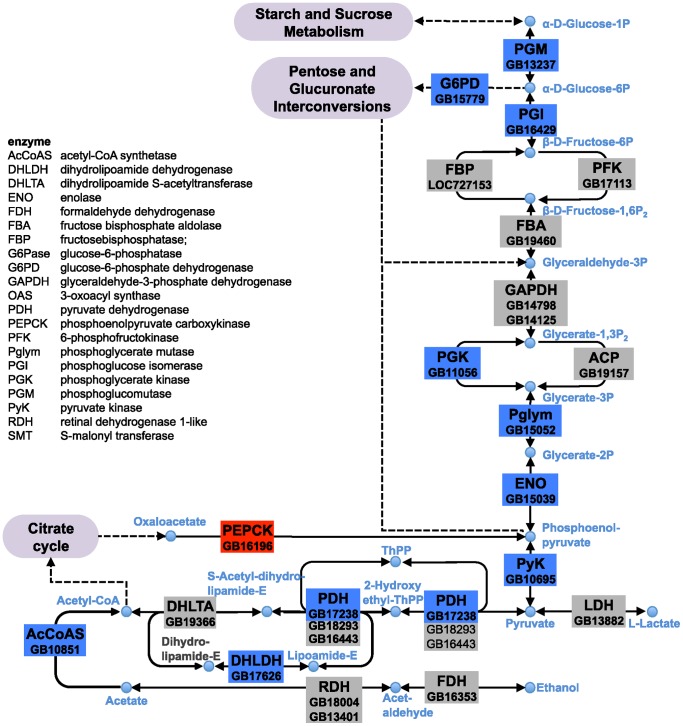
Expression of genes encoding carbohydrate-metabolising enzymes is affected in imidacloprid-exposed worker bee larvae.Genes/enzymes, including paralogues, and their positions (coloured/grey boxes) in the glycolytic and related carbohydrate pathways are placed with reference to honeybee-specific pathway variations [72], [73]. Based on DEGseq analysis, ten genes are downregulated (blue), including PGI, PGK, PGLYM, ENO and PYK, of the glycolytic pathway; PEPCK is upregulated (red). A key for gene names is provided; fold-changes in expression as determined by RNA-Seq (IE relative to C data set).